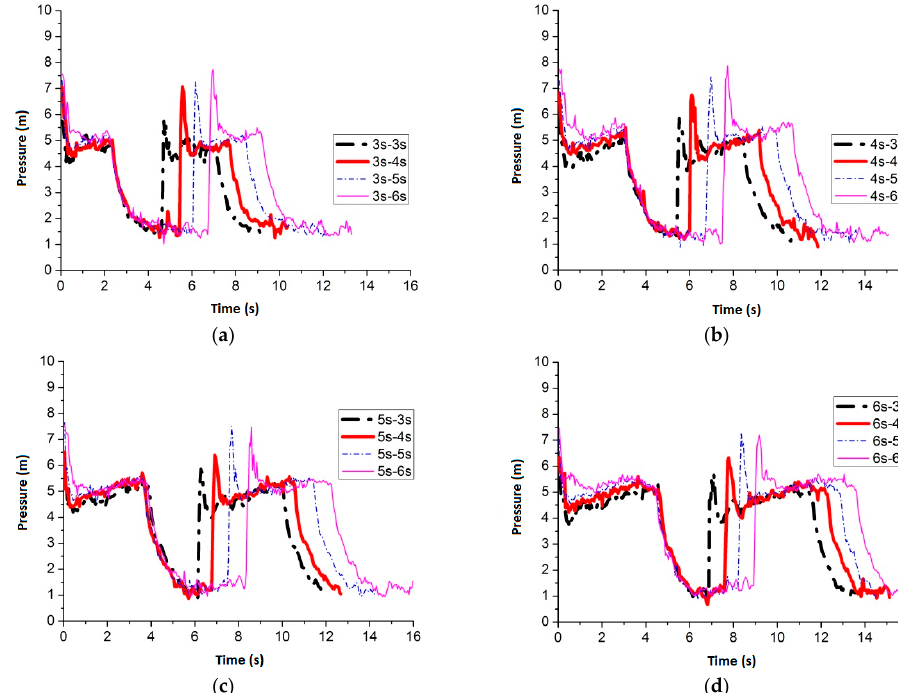
Figure 21. Pressure fluctuation of No. 1 sensing point when slot nozzle is set in the middle of the pipe ( a ) air inflow time is 3 s; ( b ) air inflow time is 4 s; ( c ) air inflow time is 5 s; and ( d ) air inflow time is 6 s.